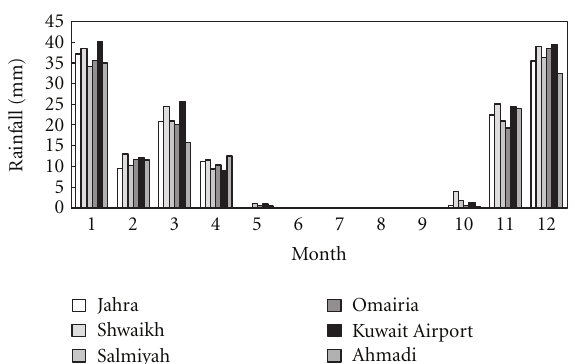
Figure 2: Seasonal mean of monthly total rainfall data calculated using (1) for the time duration from January 1994 to December 2005.